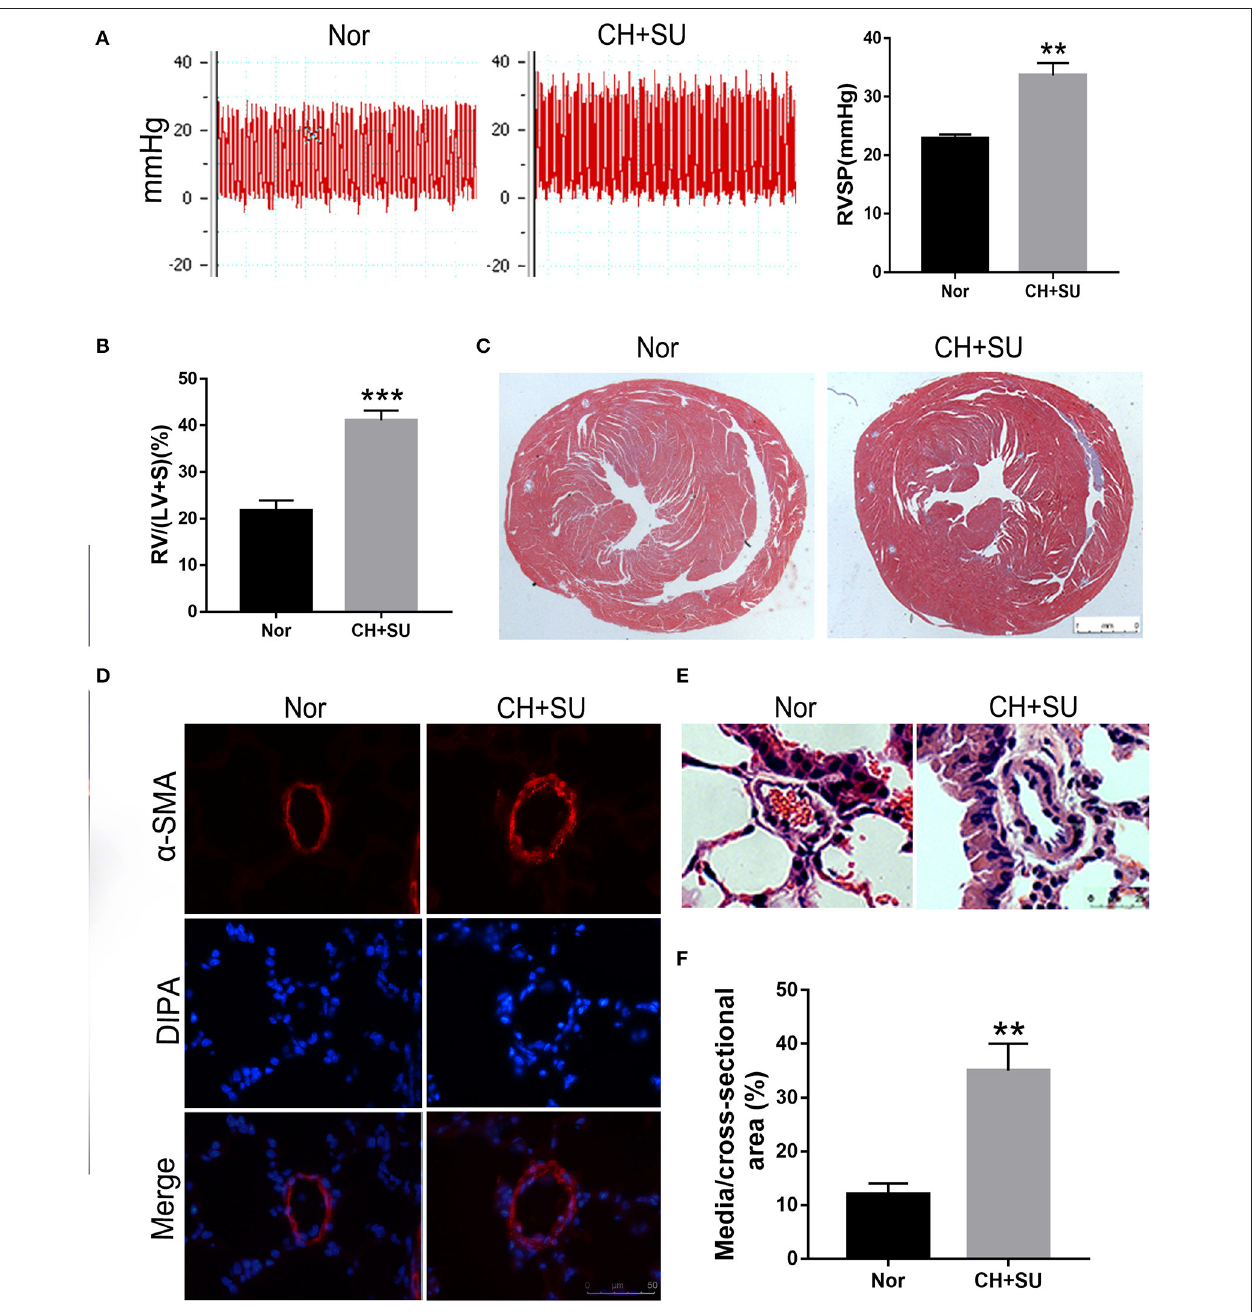
FIGURE 8 | PAH mice model. (A) Representative tracing of RVSP in mice after CH + SU or Nor treatment (left) and the mean values of RVSP in the two groups. (B) Fulton index (RV/LV + S) in mice after CH + SU or Nor treatment. (C) Representative Masson stain images of the hearts from CH + SU or Nor mice. (D) Representative α -SMA immunostaining images of lung sections from CH + SU or Nor mice. Bar, 25 µ m. (E) Representative images of H&E staining of lung sections from CH + SU or Nor mice. Bar, 25 µ m. (F) The ratio of pulmonary arterial medial thickness to total vessel size for the CH + SU or Nor mice. n = 6 in each group. ** p < 0.01, *** p < 0.001 vs. Nor group. All graphs are shown as mean ± SEM. PAH, pulmonary arterial hypertension; RVSP, right ventricular systolic pressure.